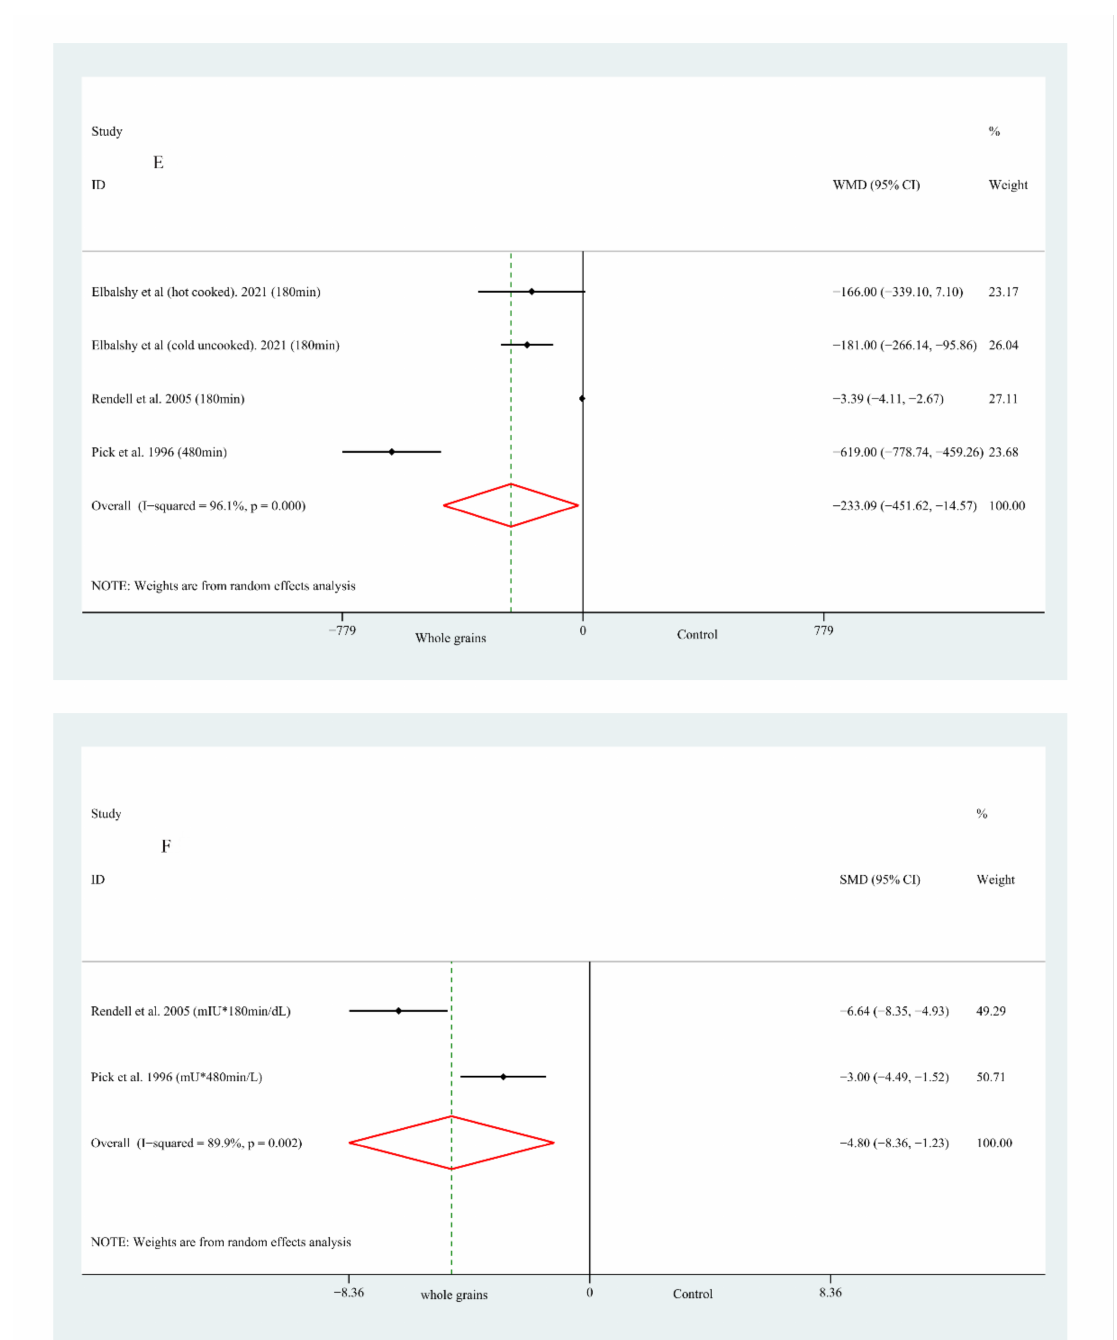
Figure 2. Forest plot of the effects of whole grain consumption on FPG ( A ), FPI ( B ), HOMA-IR ( C ), HbA1c ( D ), G-iAUC ( E ) and I-iAUC ( F ) in diabetic